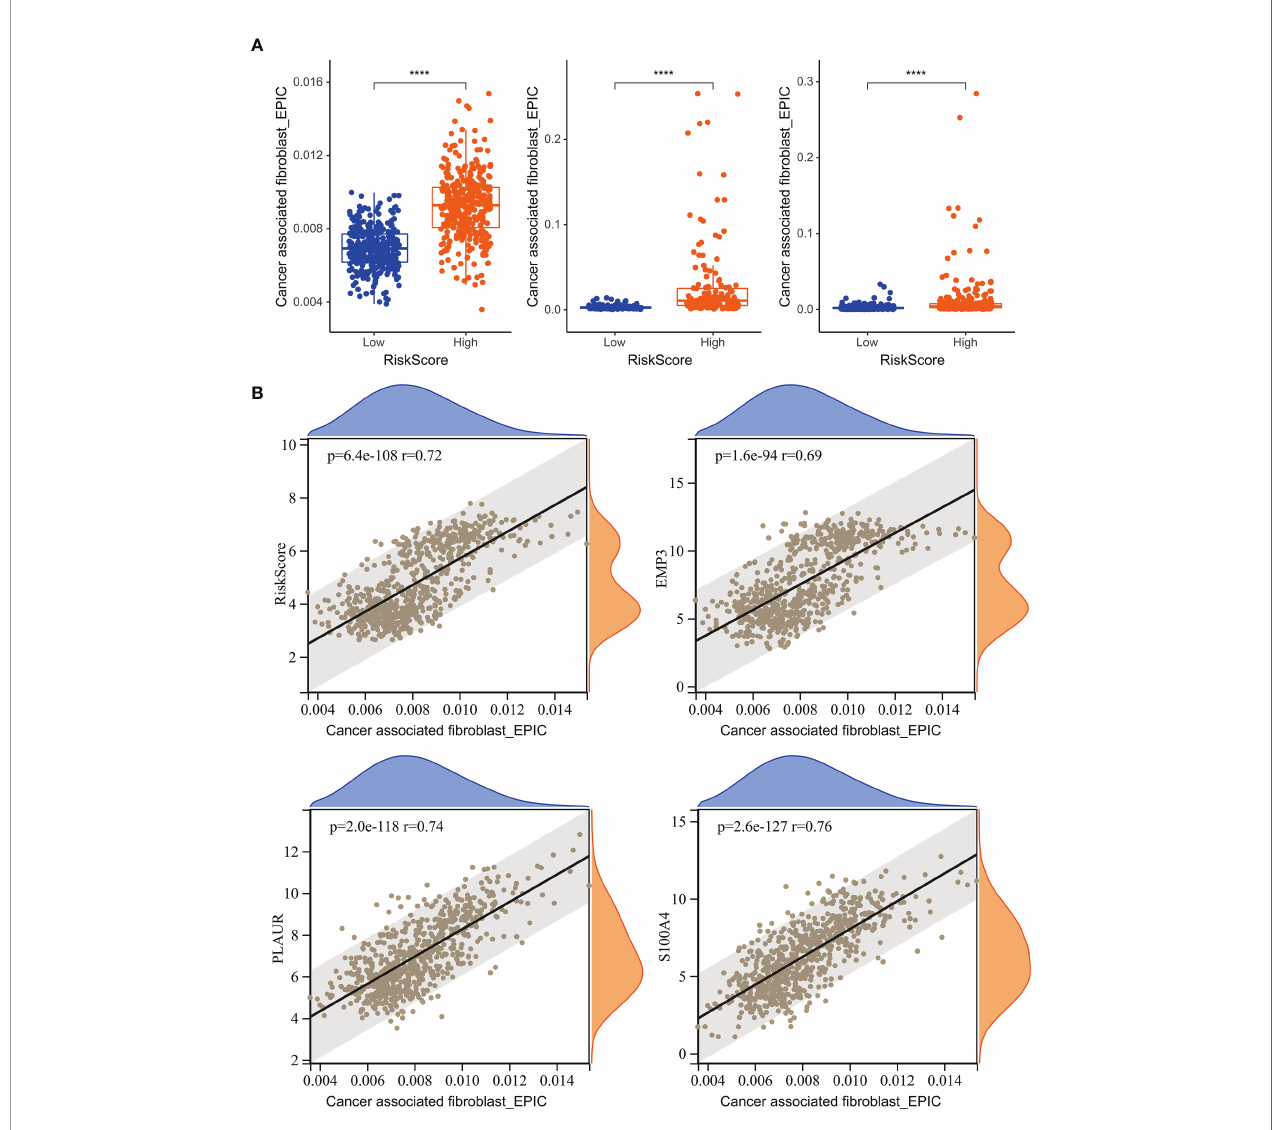
FIGURE 8 | The relationship between risk score and TAF in fi ltration. (A) Boxplot showed that TAF in fi ltration in the high-risk group was increased relative to low-risk group in TCGA GBMLGG cohort, CGGA #325 cohort, and CGGA #693 cohort, respectively. (B) Correlation analysis showed that TAF in fi ltration was signi fi cantly associated with the risk score and the prognostic genes EMP3, PLAUR , and S100A4 . ****, p <